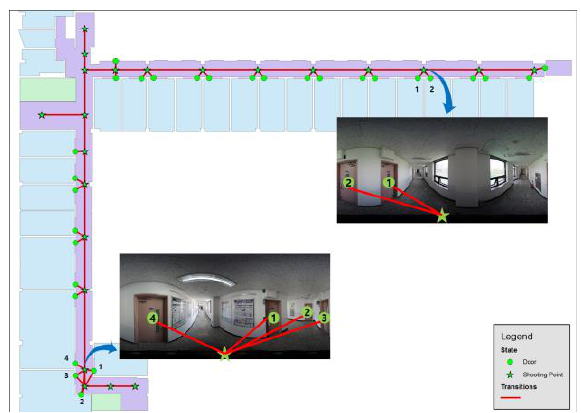
Figure 5. Generated IndoorGML data of testbed with floor plan As the Figure 5, 51 states (22 shooting points, 29 doors)